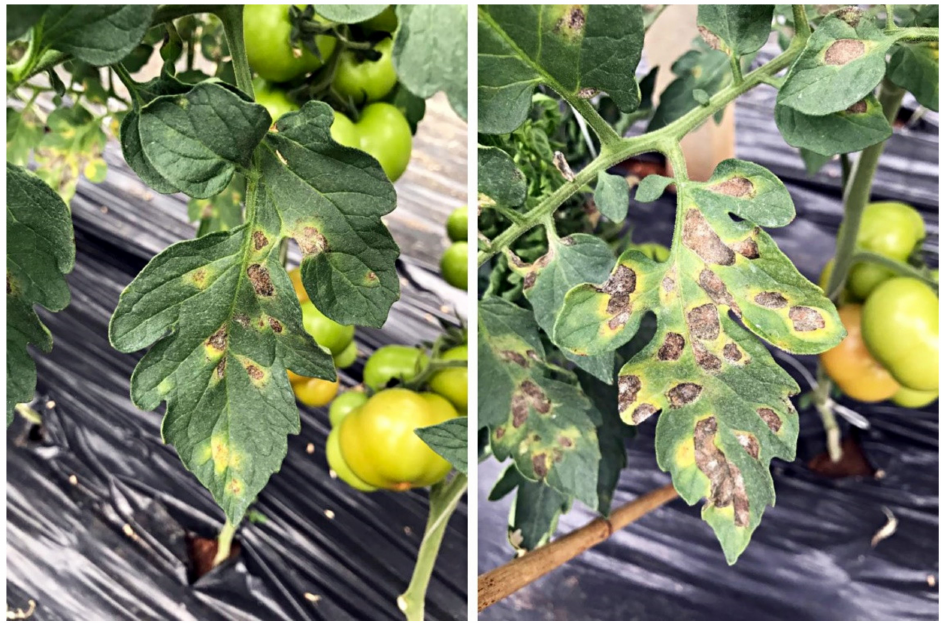
Figure 2. Leaf spot disease caused by Septoria lycopersici